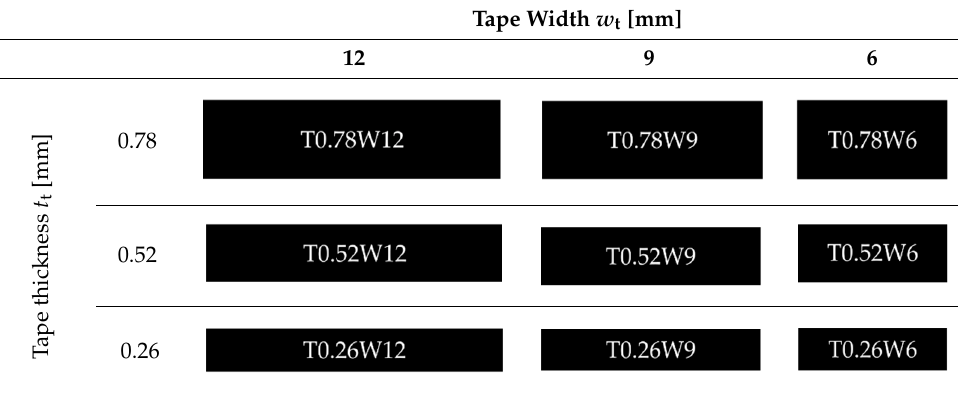
Table 2. Analyzed tape configurations and the corresponding geometric dimensions.